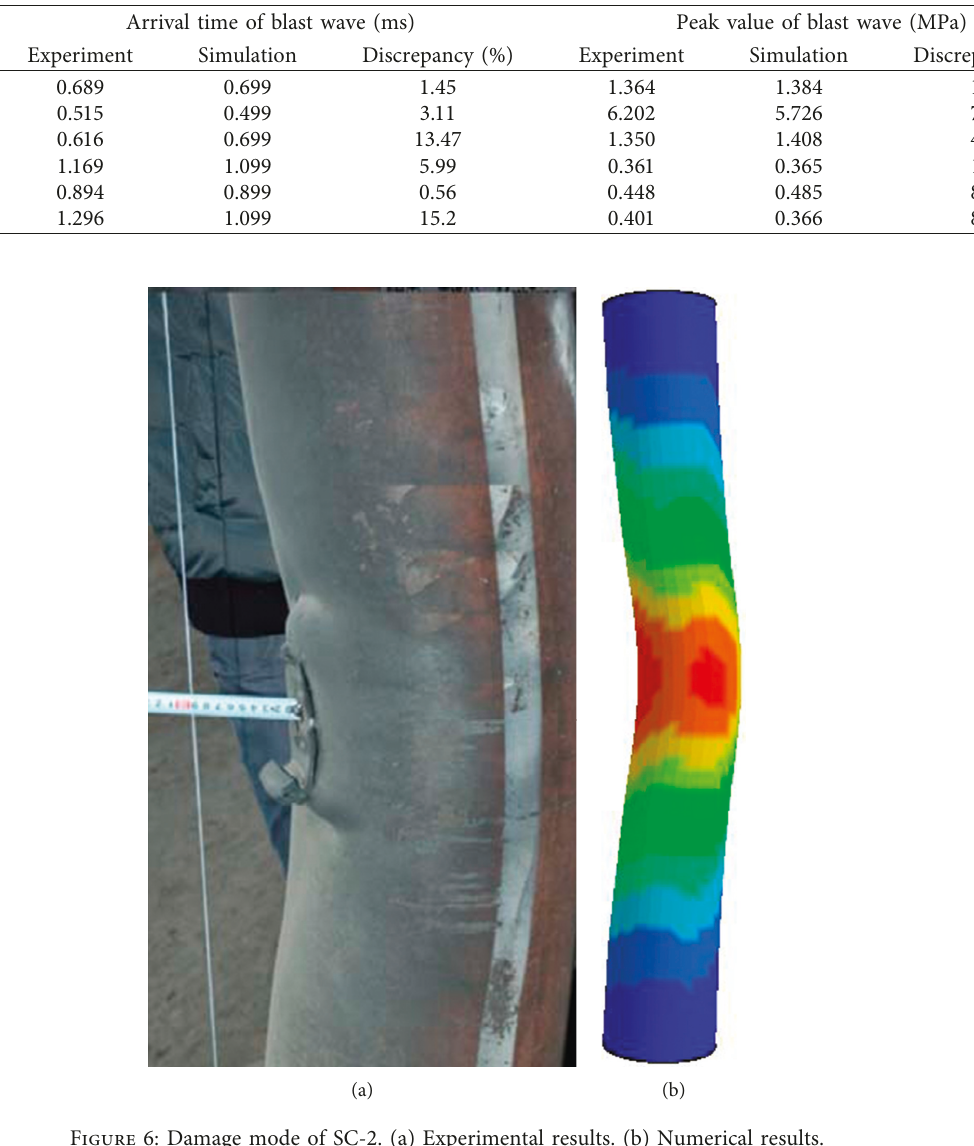
Table 7: Comparison of experimental results and numerical simulation results (SC-1).